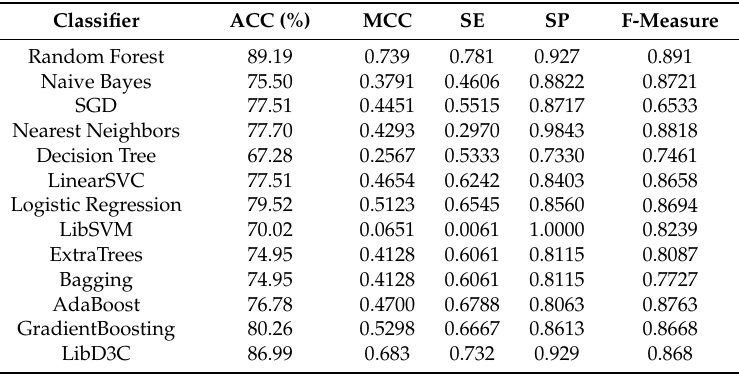
Table 3. The result of using different classifiers based on 188-D